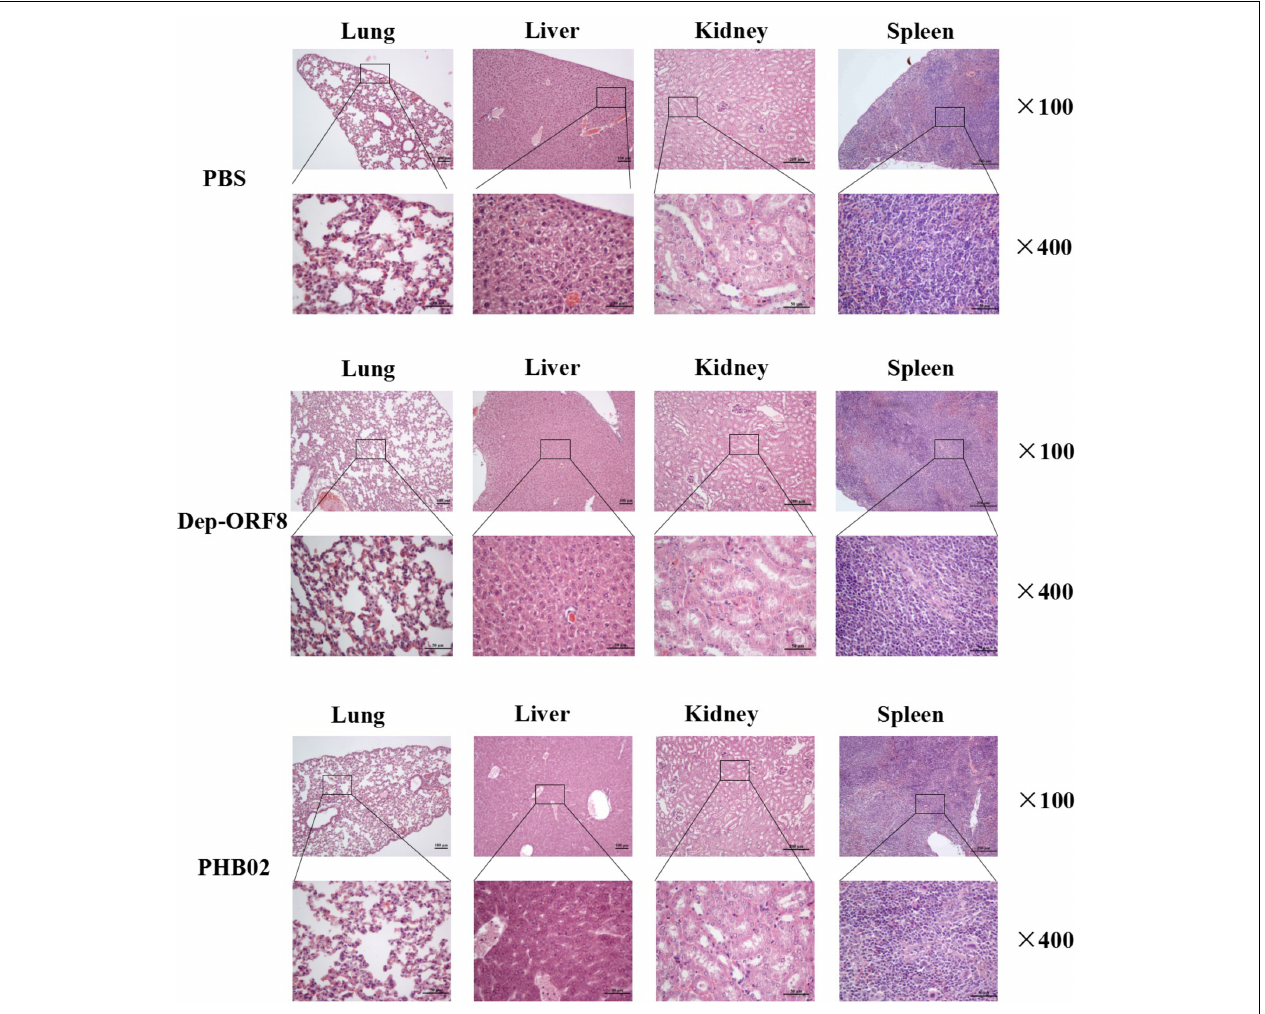
FIGURE 5 | Pathological changes and histopathology of the mice challenged with phage and depolymerase. The liver, spleen, kidney, and lungs from the mice challenged with phage and depolymerase were removed and immediately placed in 4% formalin. Tissue sections were stained with hematoxylin and eosin or toluidine blue and observed under 100 × and 400 ×